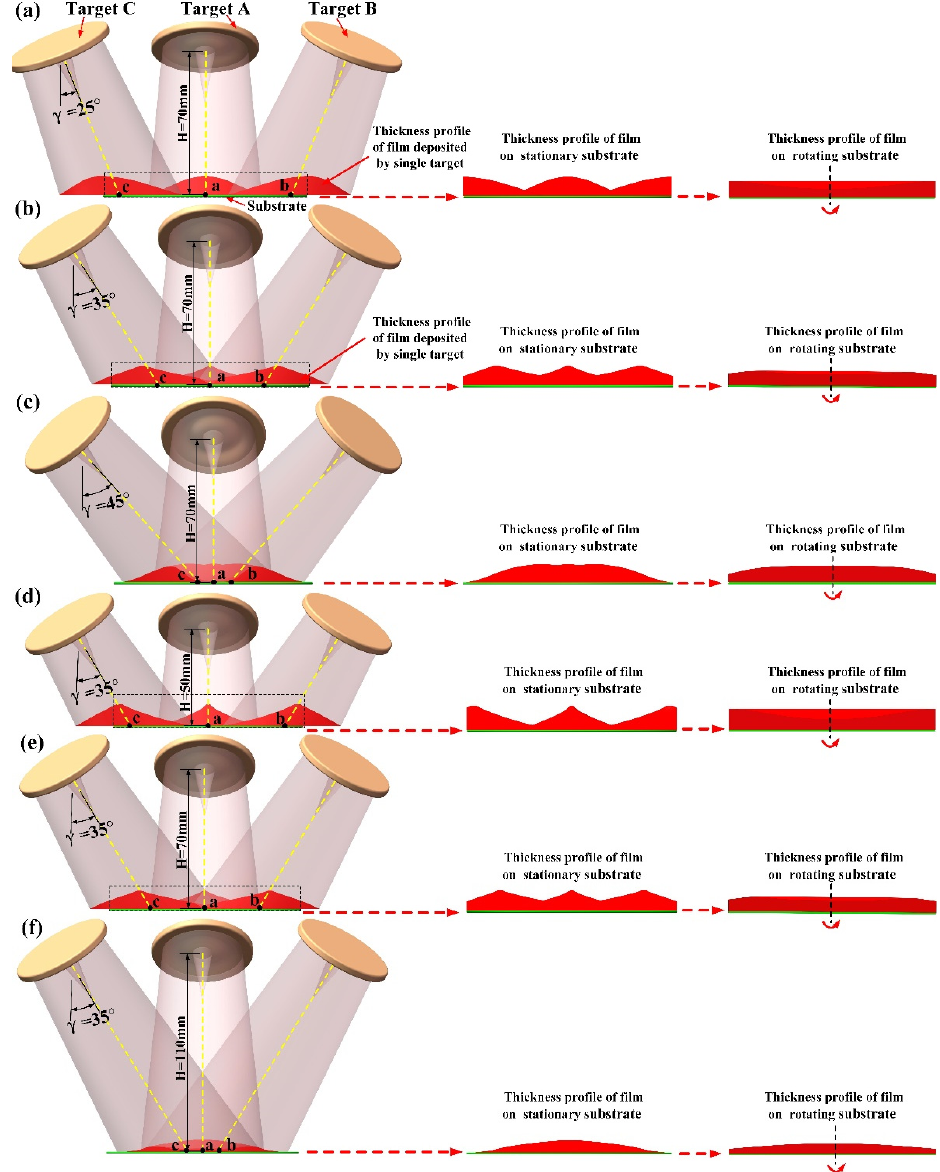
Figure 9. Schematic diagram for the formation mechanism of film thickness distribution: ( a ) H = 70 mm and γ = 25°; ( b ) H = 70 mm and γ = 35°;( c ) H = 70 mm and γ = 45°, ( d ) γ = 35° and H = 50 mm; ( e ) γ = 35° and H = 70 mm; ( f ) γ = 35° and H = 110 mm.